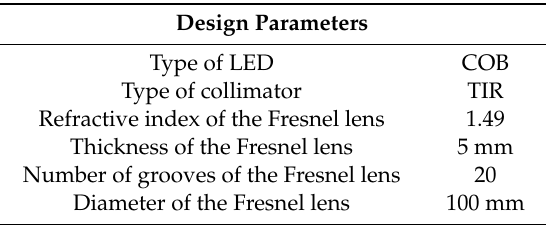
Table 1. The double Fresnel lenses design parameters.